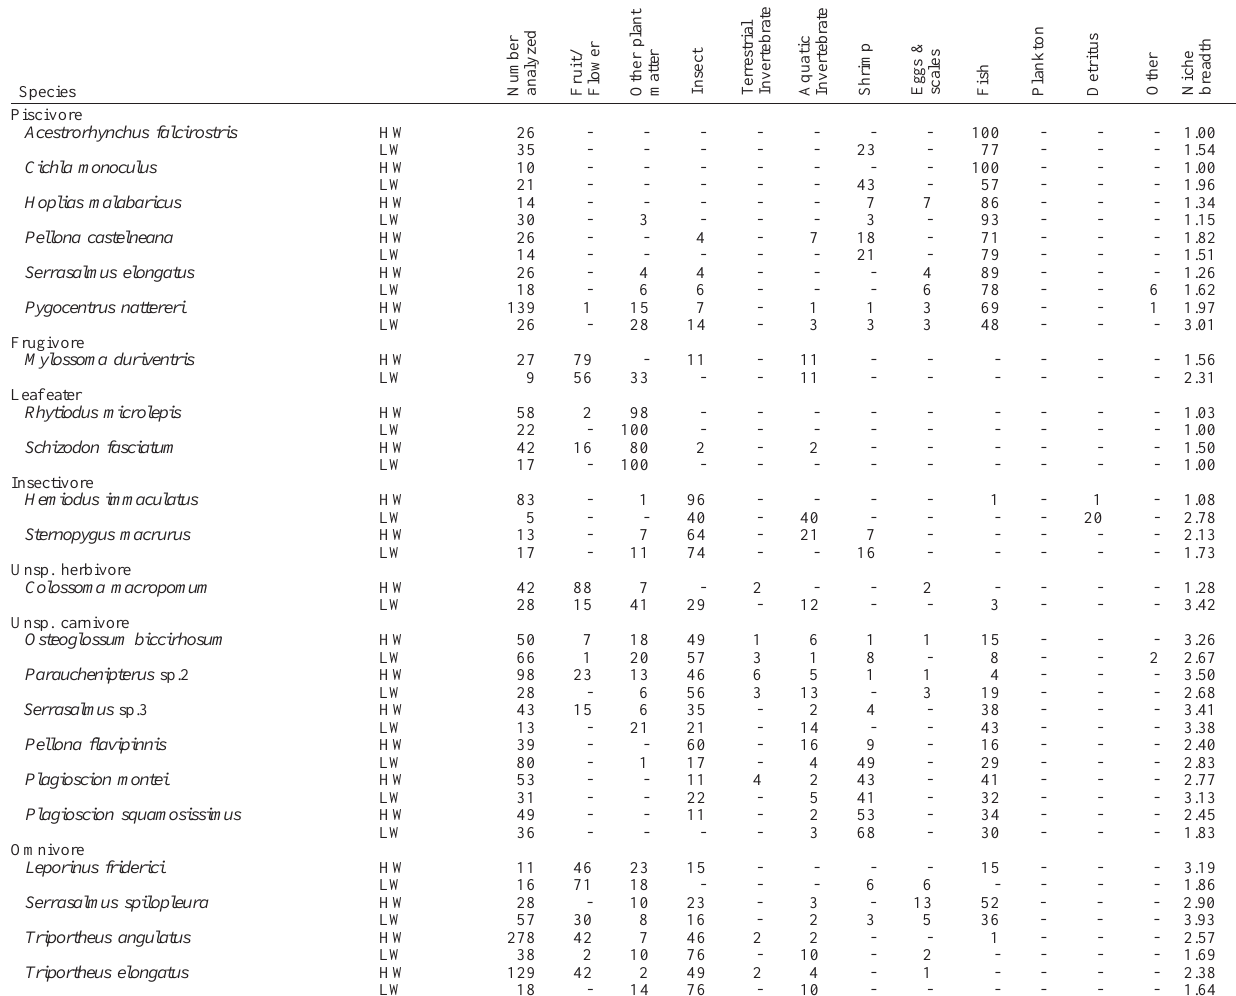
Table 2. Relative abundance (percent) of food items observed in stomachs of selected species and niche breath during low (LW) and high water (HW) seasons in lago do Rei,